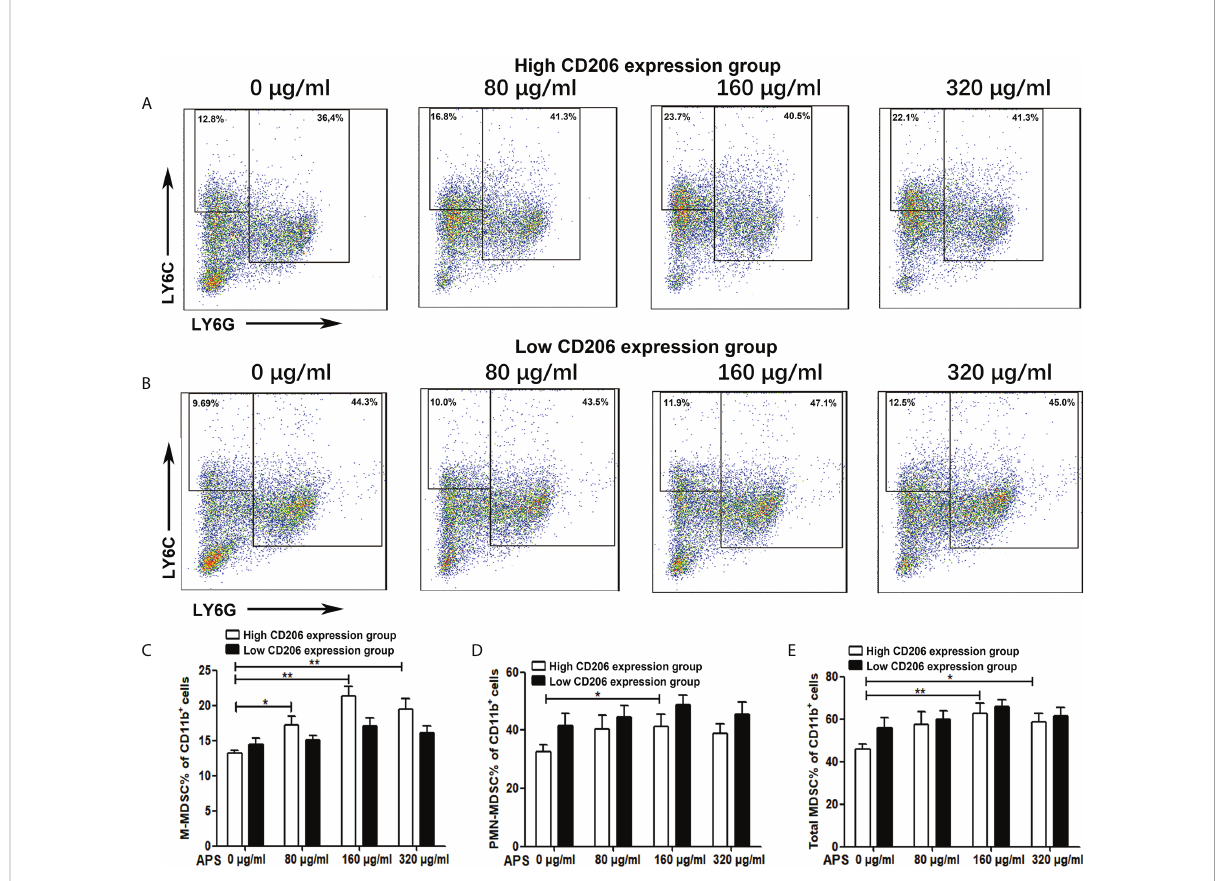
FIGURE 2 The effect of APS on MDSC differentiation. BMC which were isolated from normal mouse and were divided into the MR (CD206) high expression group and the MR (CD206) low expression group. Then they were treated with APS (0, 80, 160 and 320 m g/ml) for 96h in the presence of GM-CSF. (A, B) One representative result from each experiment is shown. The percentages of M-MDSC (C) , PMN-MDSC (D) and total MDSC (E) among the induced MDSC in vitro (**p<0.01, *p<0.05). n=5, Data are expressed by mean ±